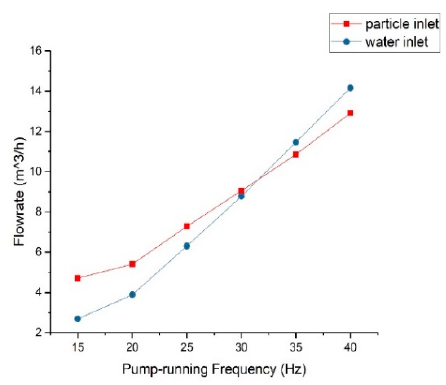
Figure 6. Relationship between flow rates of inlets and pump-running